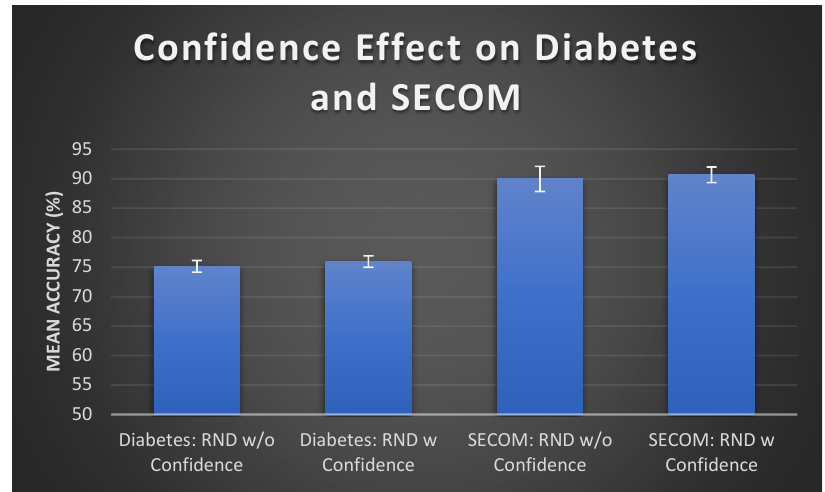
Figure 7. Mean accuracy with standard deviation bars of AutoKNN on Diabetes and SECOM datasets.